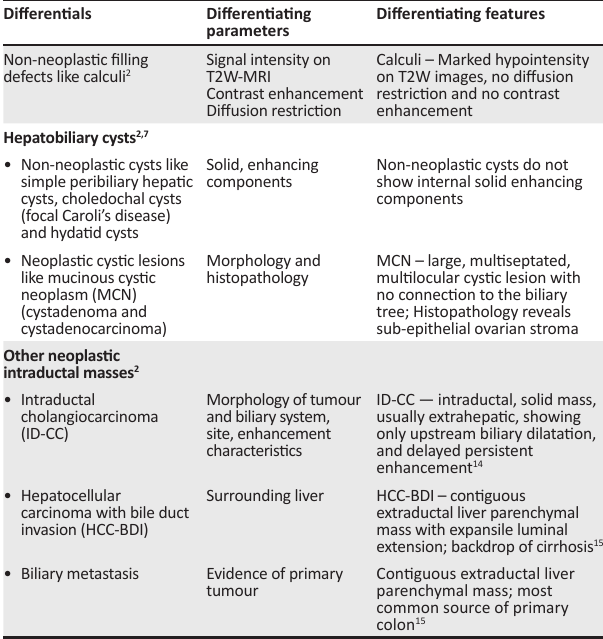
TABLE 1: Differential diagnoses of intrahepatic, intraductal solid-cystic tumours. Differentials Differentiating Differentiating parameters